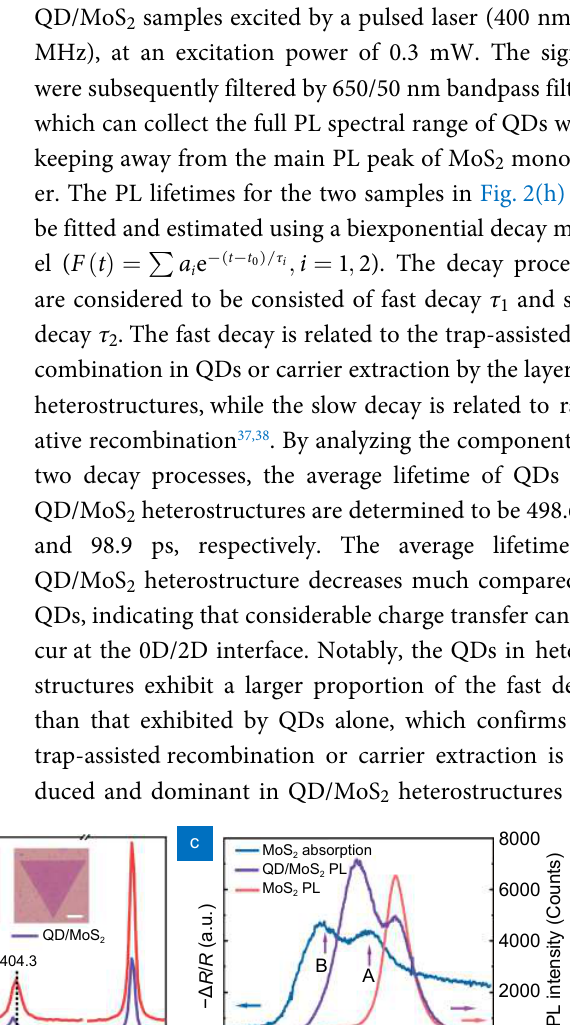
mapping measurements, and all the scale bars in Fig. 2(d−g) are 5 μm.